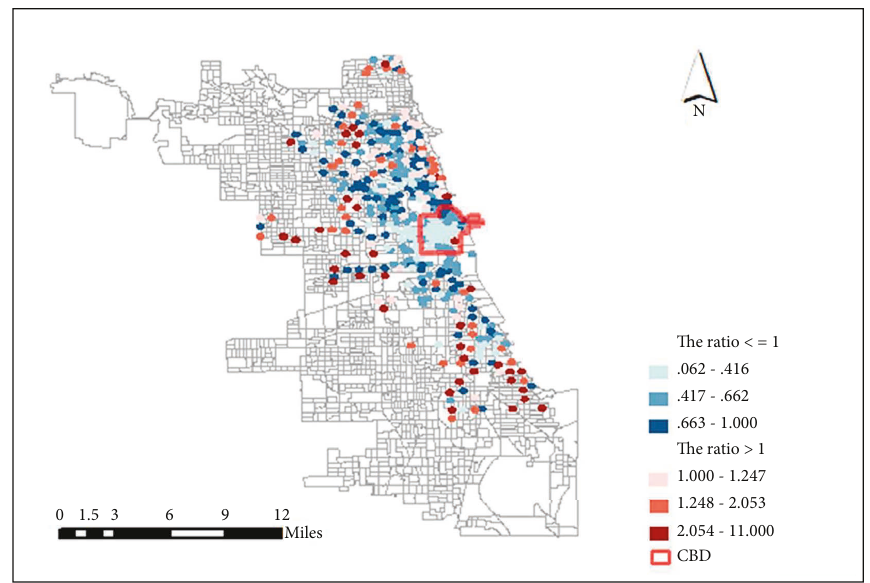
Figure 4: Spatial distribution of the ratio of ridership during COVID-19 to that before COVID-19.